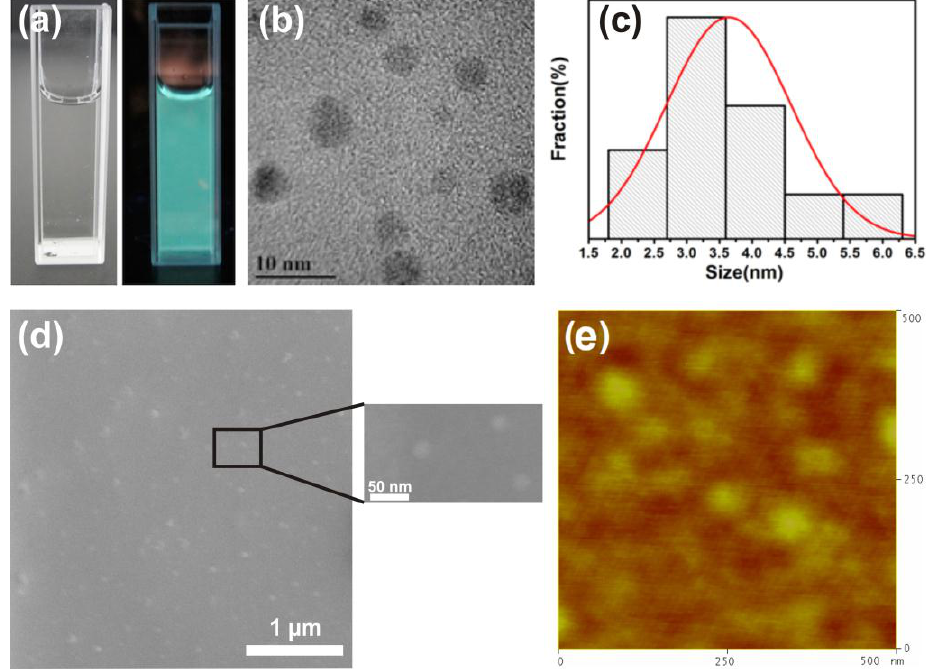
Figure 2. ( a ) GQD dispersed in water under natural light (left) and UV light (right); ( b ) High resolution transmission electron microscopy (TEM) image of GQDs; ( c ) Size distribution of GQDs. (The